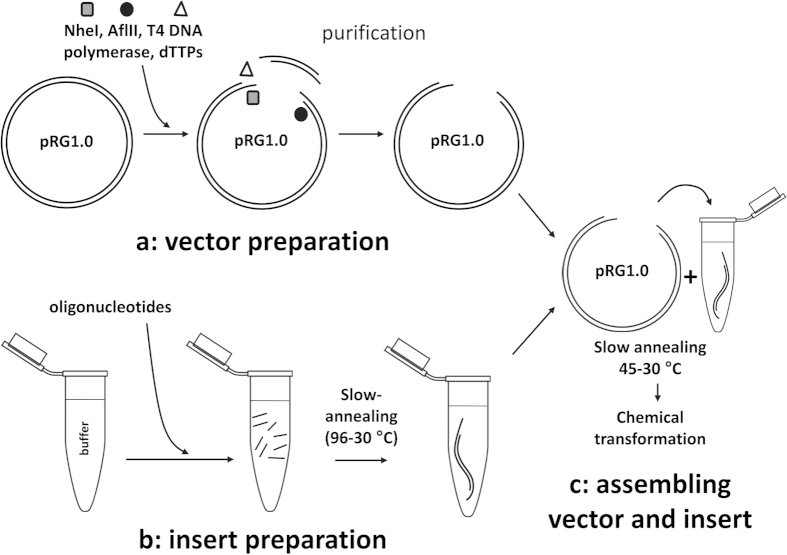
RapGene overview.(a) Plasmid pRG1.0 is digested simultaneously with AflII and NheI in the presence of T4 DNA polymerase and dTTPs to generate long 3’-recessed cohesive ends to accommodate the annealed oligonucleotides. (b) Oligonucleotides for each gene assembly are pooled in a buffered solution and then subjected to slow annealing (96 °C to 30 °C) for up to two hours. (c) Vector and pre-annealed oligonucleotides are further incubated from 45 °C to 30 °C in a 10 μl reaction. This mix is used to transform E. coli. Transformations are plated on LB supplemented with ampicillin and IPTG.